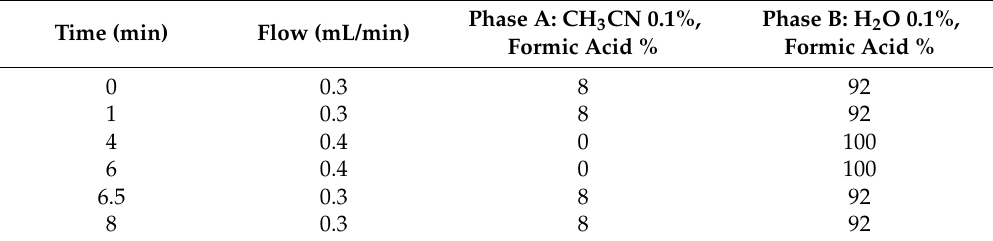
Table 2. Chromatograph